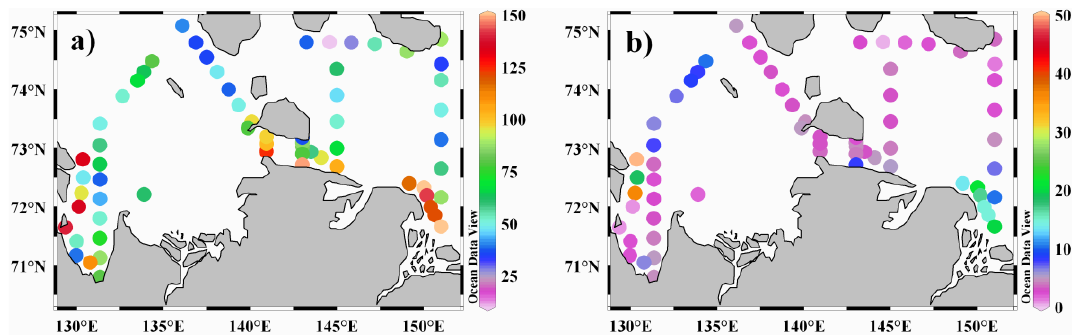
Fig. 9. Distribution of 1p CO 2 (µatm) and CO 2 fluxes ( F CO 2 , mmolm − 2 d − 1 ) between the surface water and atmosphere in the Laptev Sea, September